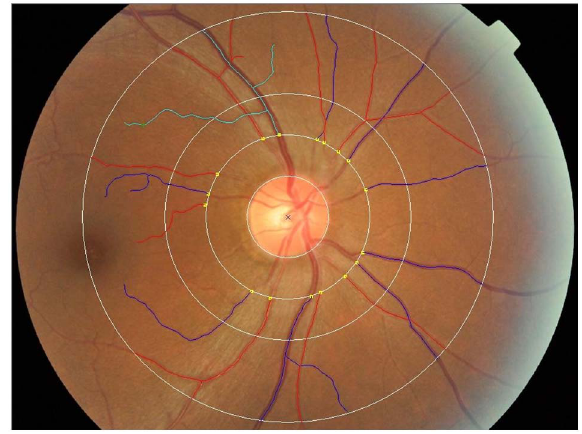
Figure 1. Fundus photographs processed by SIVA version 3.0 software. Test zone was 0.5- to 2.0-disc diameters away from the optic disc margin. A red line represents an artery and a blue line represents a vein. Fractal dimension, D(f), is a complexity indicator determined by reactive vessels obtained from vascular tracking through the box counting dimension